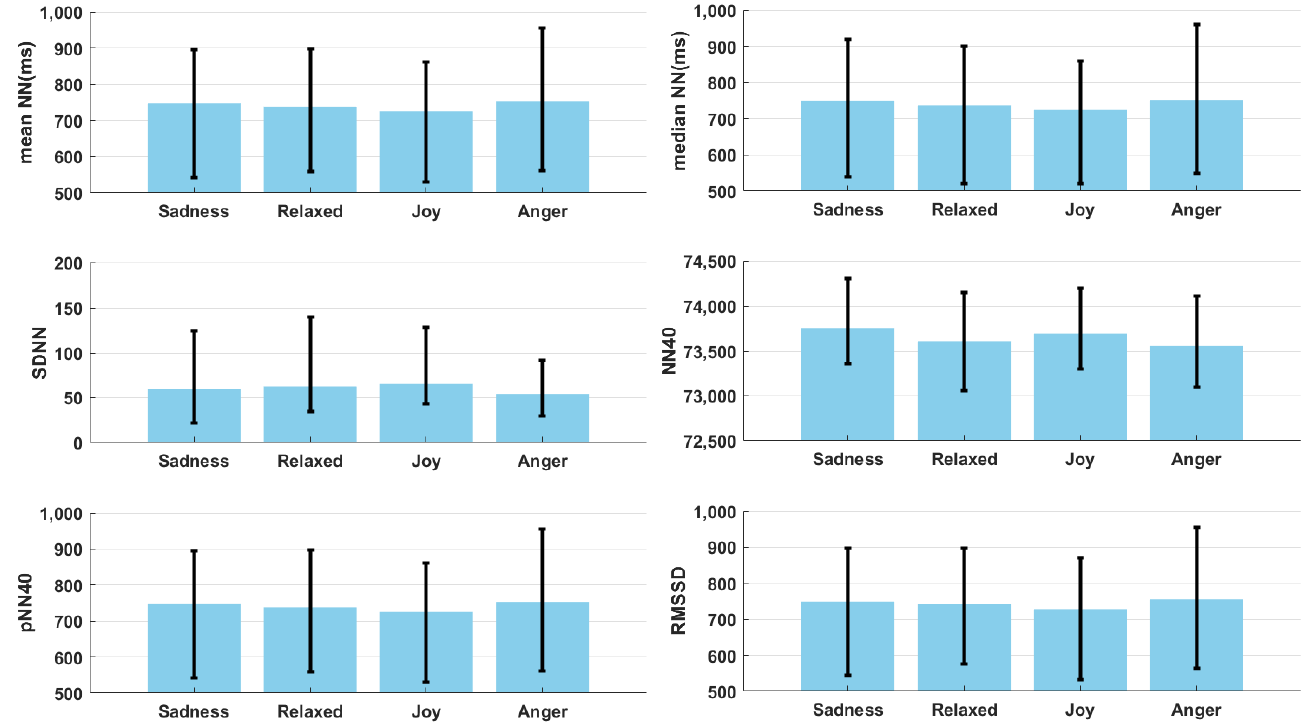
Figure 4. Statistics of time domain features.